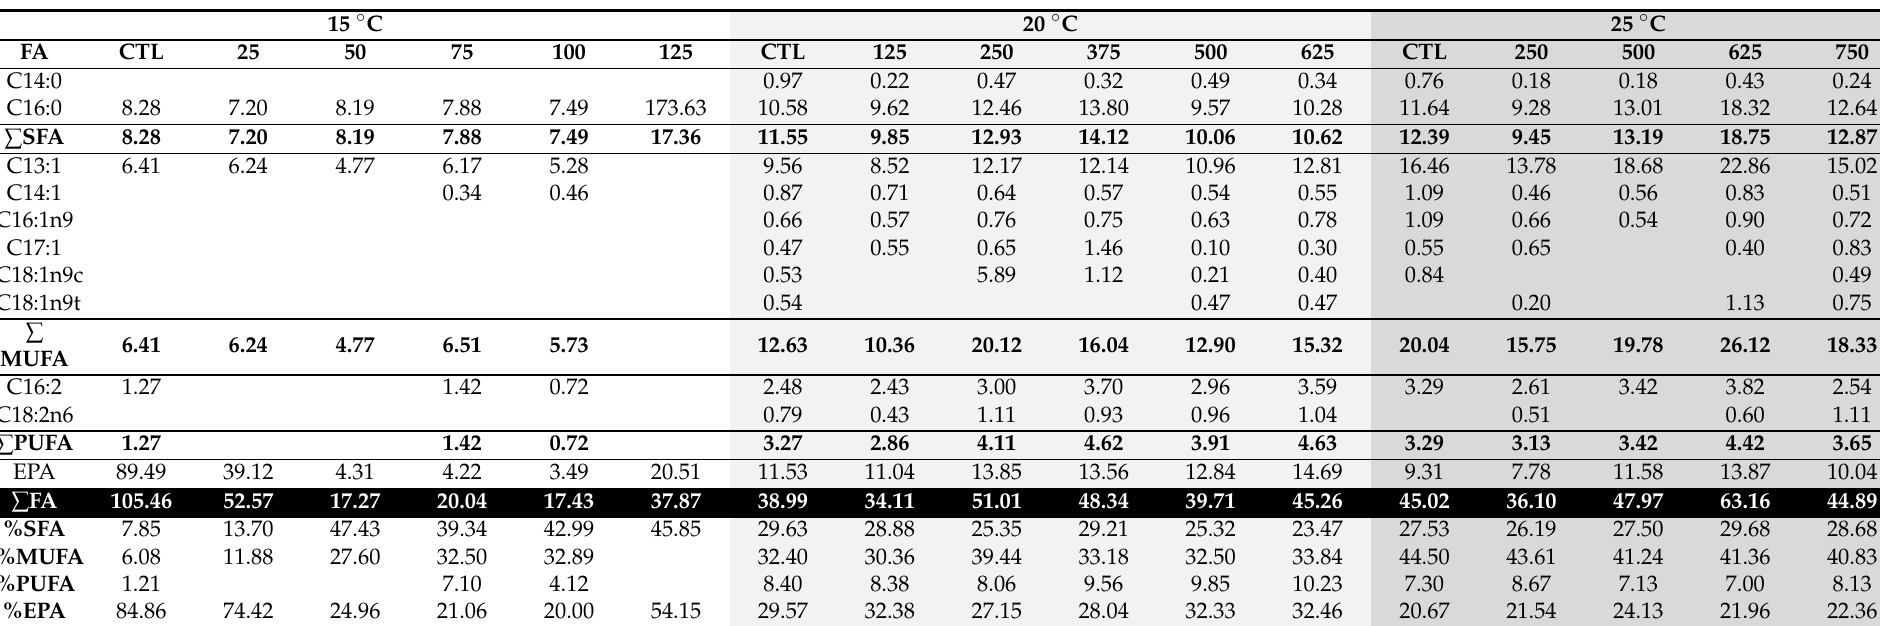
Table 3. Quantification of fatty acid profiles (SFA, MUFA, PUFA, and HUFA at µ g/10 4 cell and expressed in %) of Thalassiosira weissflogii , determined in organisms after 7 days of exposure to different concentrations of copper sulfate ( µ g/L) at three different temperatures (15 ◦ C (white); 20 ◦ C (light gray); 25 ◦ C (dark